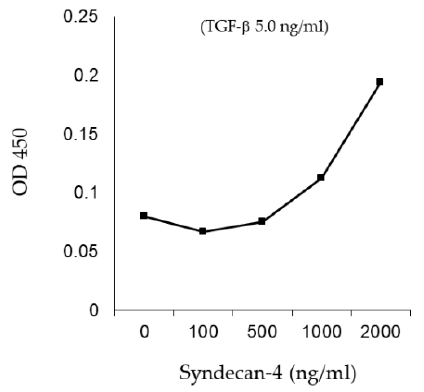
Figure 9. Binding of recombinant TGF- β and syndecan-4. In vitro binding assay showed a dose-dependent binding of recombinant TGF- β to recombinant syndecan-4.